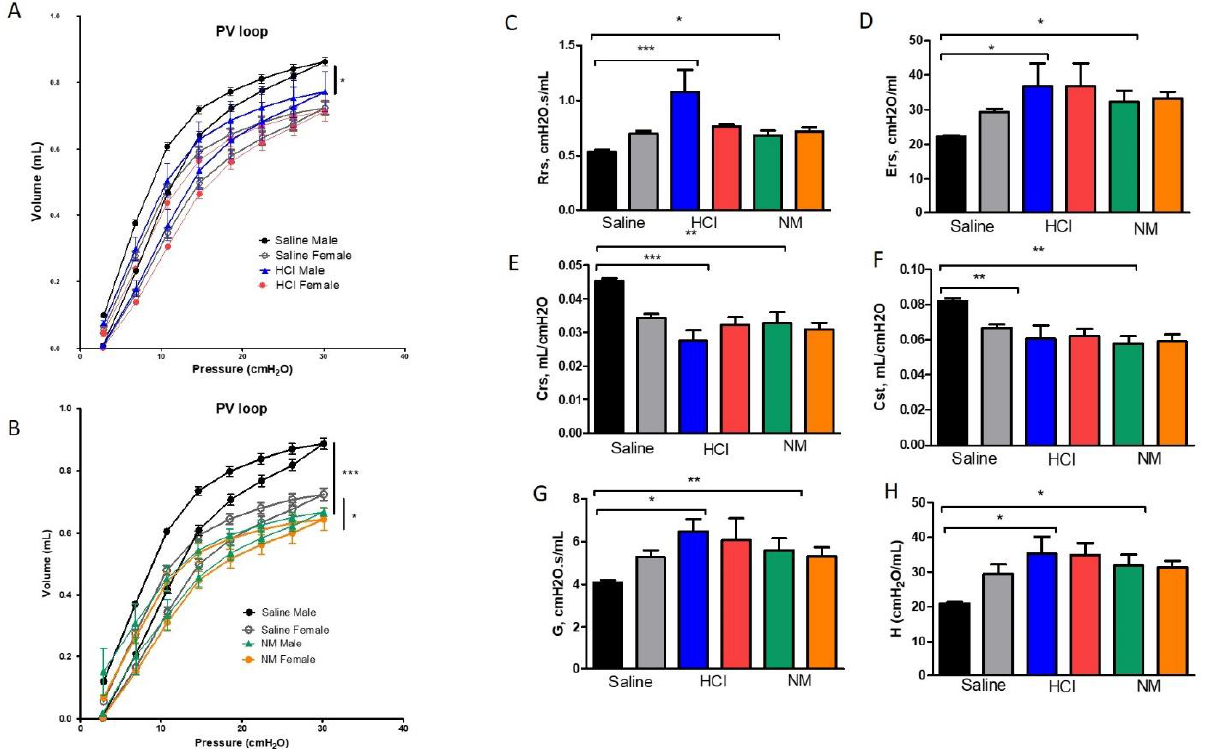
Figure 6. Gender differences in HCl and NM-induced alterations in lung mechanics. ( A , B ) Either HCl or NM provoked a downward shift in pressure-volume loops (PV loops), with the highest effect observed in male mice. ( C , D , G , H ) Male mice instilled with either HCl or NM, showed an increase in total respiratory system resistance (Rrs), total elastance (Ers), tissue elastance ( H ), and damping ( G ). ( E , F ) Respiratory system compliance (Crs) and static compliance (Cst) were reduced in HCl and NM-treated male mice. Means ± SEM; n = 3 – 4 mice per group; * p < 0.05, ** p < 0.01, *** p < 0.001, ns: not significant, with one-way ANOVA and Tukey’s.